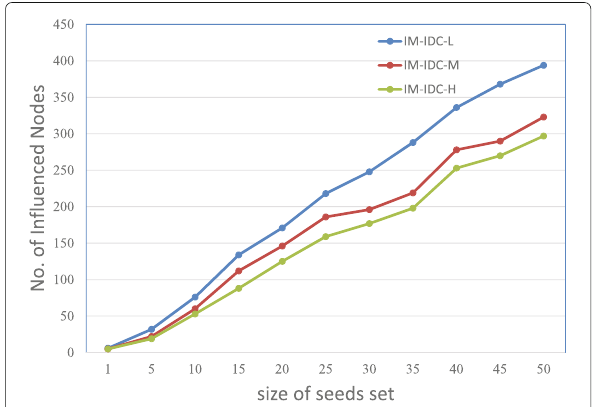
Fig. 3 The No. of influence set size on DBLP data while increasing the size of seed nodes, where IM-IDC-L, IM-IDC-M, and IM-IDC-H are A PPRO IM-IDC with low , medium , and high context cardinalities